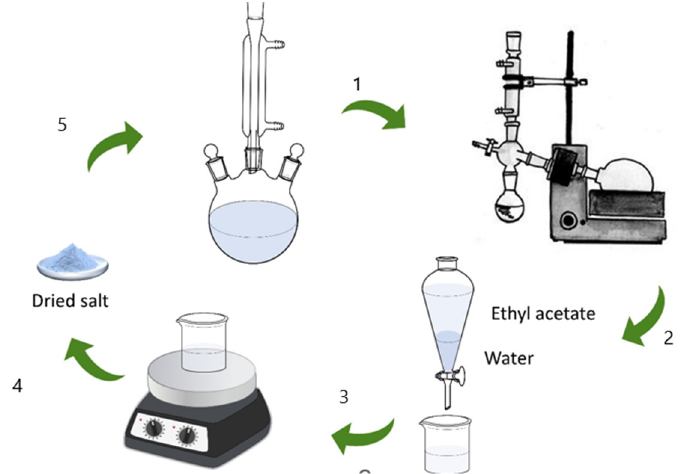
Figure 12. Procedure to recover and reuse the soluble catalyst [27]. After the catalytic run, the solvent of the reaction is removed in a rotatory evaporator, and the neat remaining is extracted with a mixture of water/ethyl acetate. The Keggin HPA salt catalyst is soluble in water, which is evaporated, giving the solid catalyst. Afterwards, it is weighted and used in another catalytic cycle. Table 2 shows the conversion and recovery rates obtained after the successive cycles of recovery/reuse. Table 2. The recovery rates and conversions achieved in the reuse of Cu 2 SiW 12 O 40 catalyst in oxidative esterification reactions of furfural with hydrogen peroxide [27]. Cycle